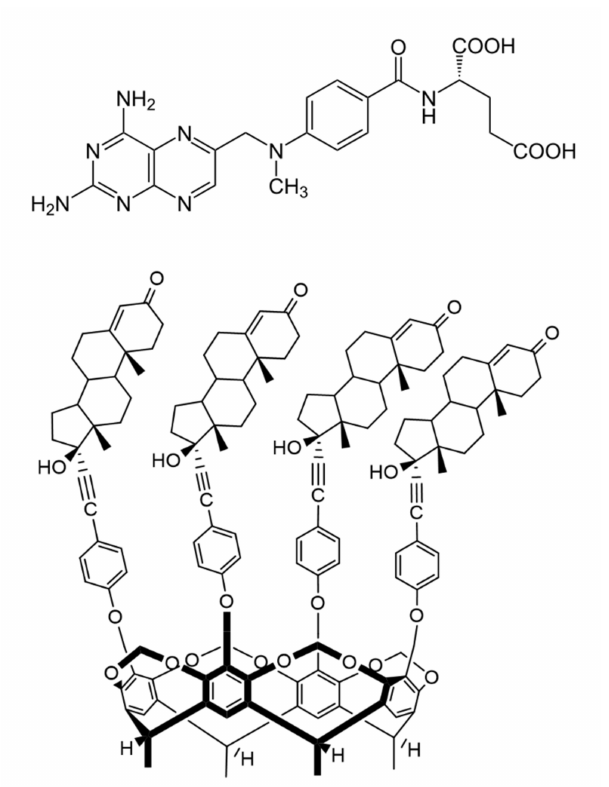
Figure 1. Chemical structure of antirheumatic and antitumor drug methotrexate (MTX, top) and the macrocyclic host molecule tetrakis(androst-4-en-3-one-17 α -ethinyl)-cavitand (TAC, bottom) (8 β -H, 9 α -H and 13 α -H are omitted for